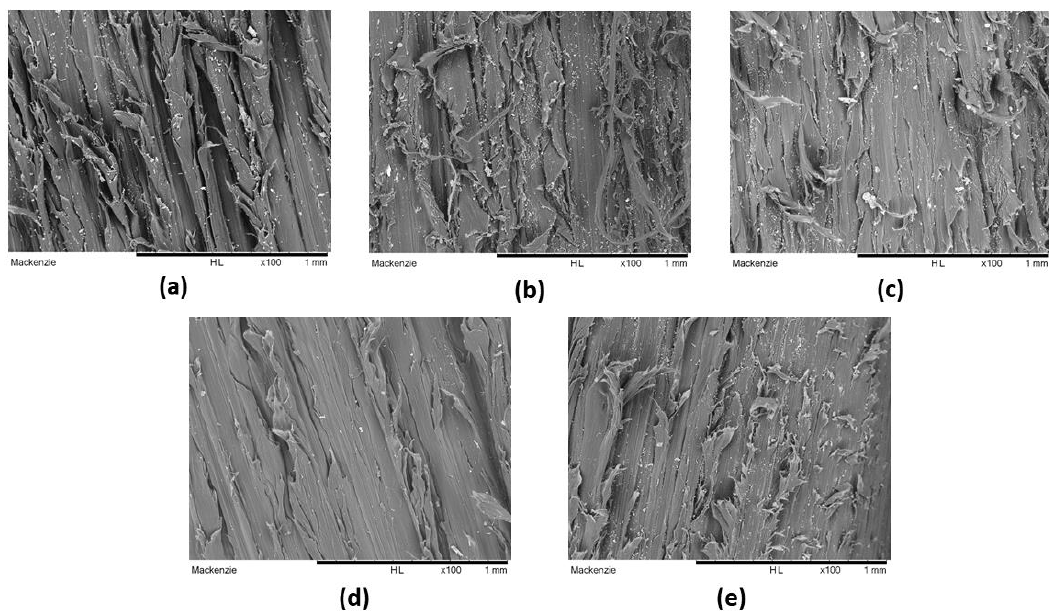
Figure 5. Images of the worn surface of the HMWPE ( a ), UHMWPE ( b ), HMWPE-UHMWPE (80/20 wt.%) ( c ), HMWPE- mGO (0.1 wt.%) ( d ) and HMWPE-UHMWPE (80/20 wt.%)-mGO (0.1 wt.%) ( e ) after the abrasive test.